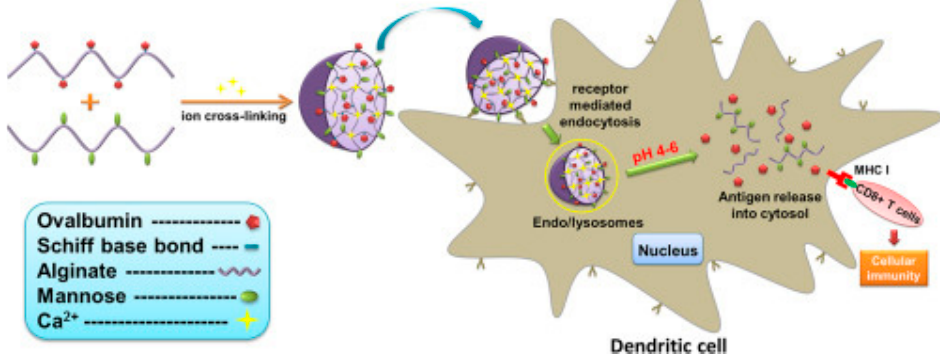
Figure 3. Illustration of the potential use of functionalized alginate nanoparticles as a nanovaccine for cancer immunotherapy. Reproduced with permission from [97]., 2017, Elsevier.